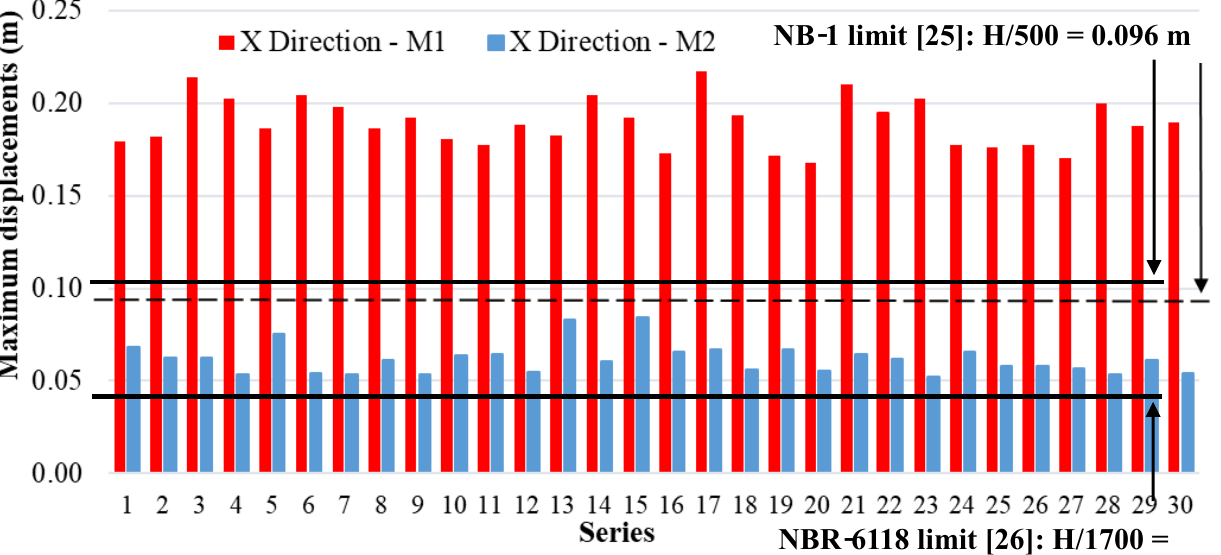
NB-1 limit [25]: H/500 = 0.096 m